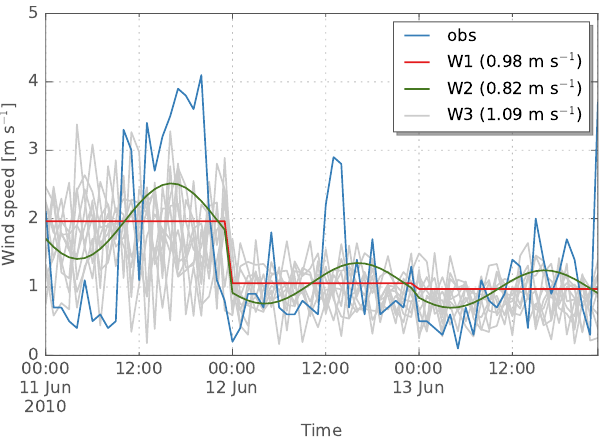
Figure 5. Example application of the wind disaggregation models W1, W2 and W3 for Obergurgl. Observed and disaggregated time series are shown for wind speed. For option W3, 10 realisations are shown. The numbers in parentheses indicate the root mean square error (RMSE) computed for each